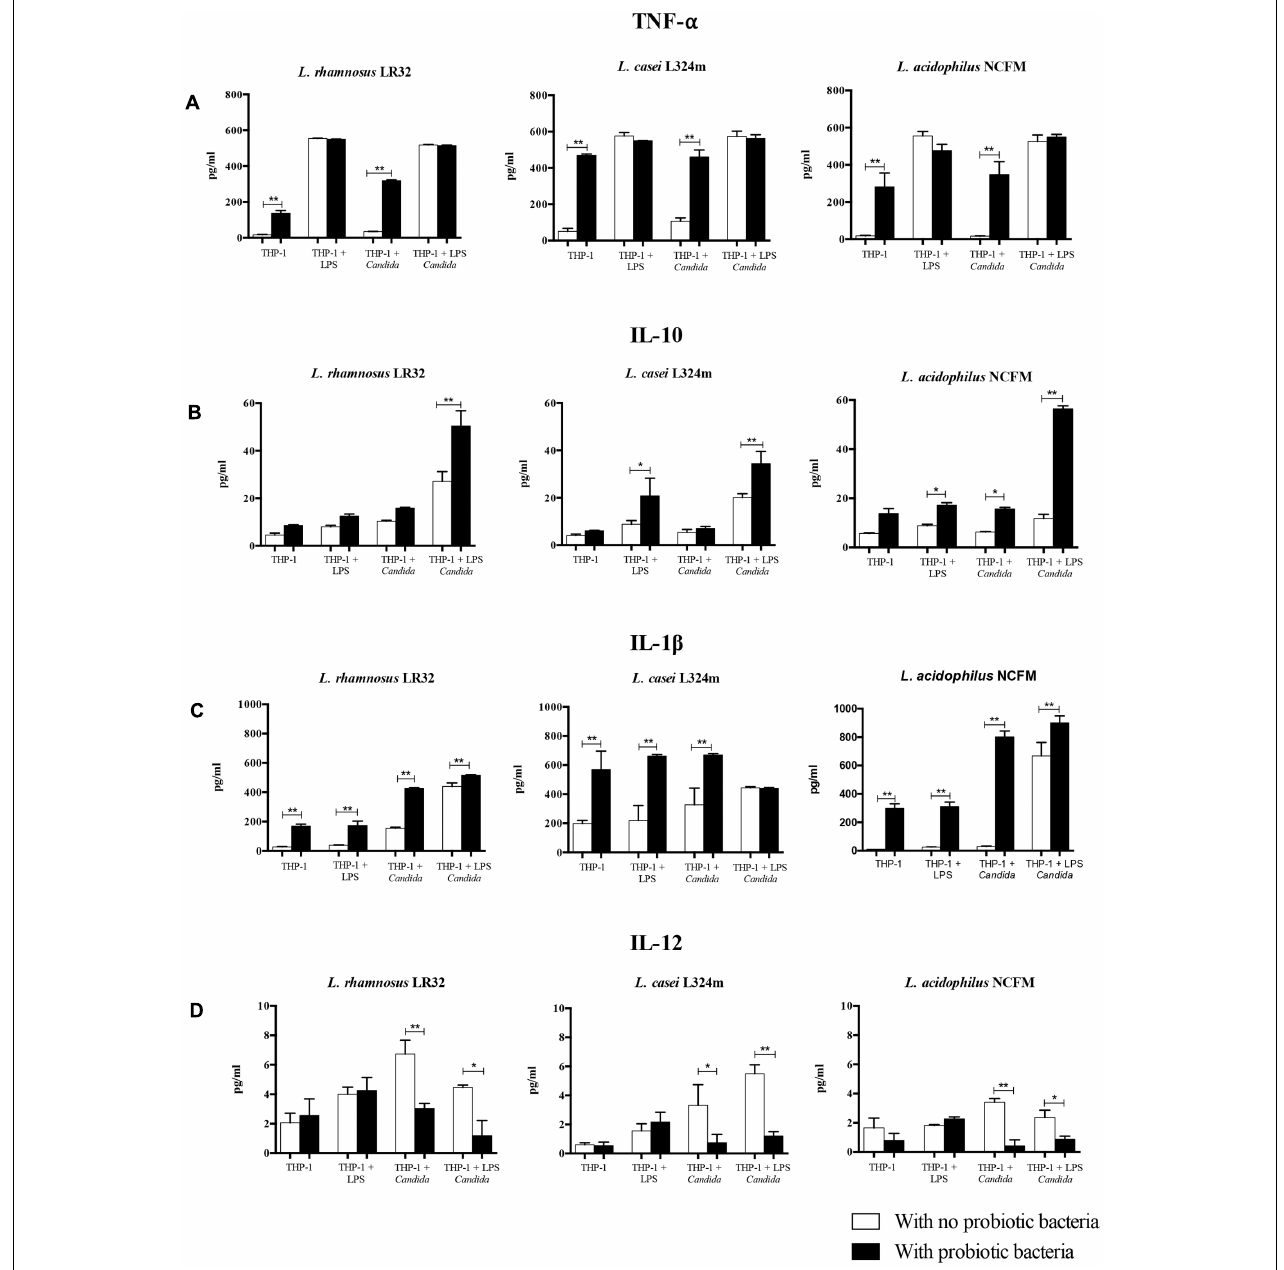
FIGURE 3 | Effect of probiotic bacteria pretreatment on the production of TNF- α (A) , IL-10 (B) , IL-1 β (C) , and IL-12 (D) by macrophages. The quantification of cytokines in the macrophage supernatants was determined by ELISA. Eight groups of study were performed for each Lactobacillus strain tested: Group 1 – THP-1 (negative control); Group 2 – THP-1 + Probiotic pretreatment; Group 3 – THP-1 + LPS challenge; Group 4 – THP-1 + Probiotic pretreatment + LPS challenge; Group 5 – THP-1 + Candida challenge; Group 6 – THP-1 + Probiotic pretreatment + Candida challenge; Group 7 – THP-1 + LPS pretreatment + Candida challenge; and Group 8 – THP-1 + LPS and Probiotic pretreatments + Candida challenge. Three different strains of probiotic bacteria were tested: Lactobacillus rhamnosus LR32, Lactobacillus casei L324m, and Lactobacillus acidophilus NCFM. Data are presented as mean ± SD of three independent experiments. ∗ p < 0.05; ∗∗ p <